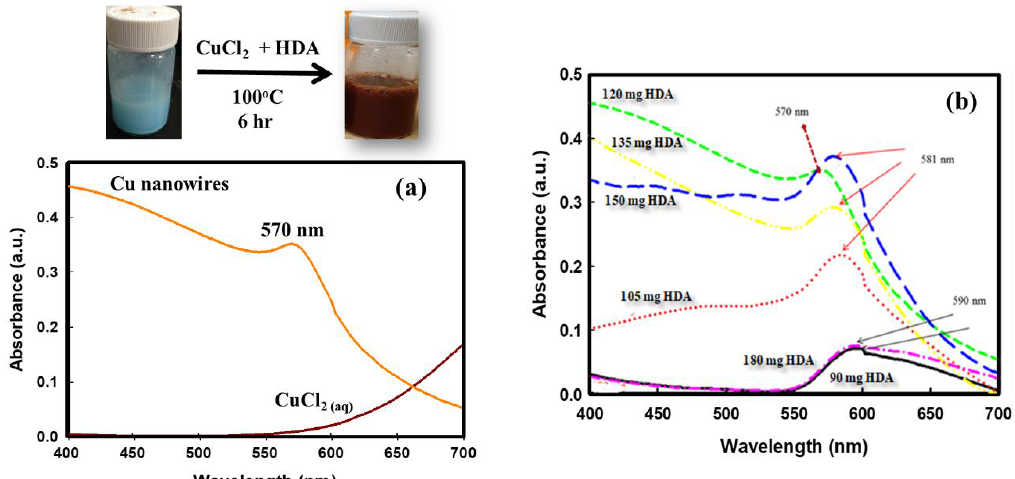
Figure 2. UV-Vis spectra and photographs of the samples of the CuNWs solutions. ( a ) UV-Vis spectra for both CaCl 2 and CuNWs solution. ( b ) UV-Vis spectra of CuNWs solutions under various HAD contents.